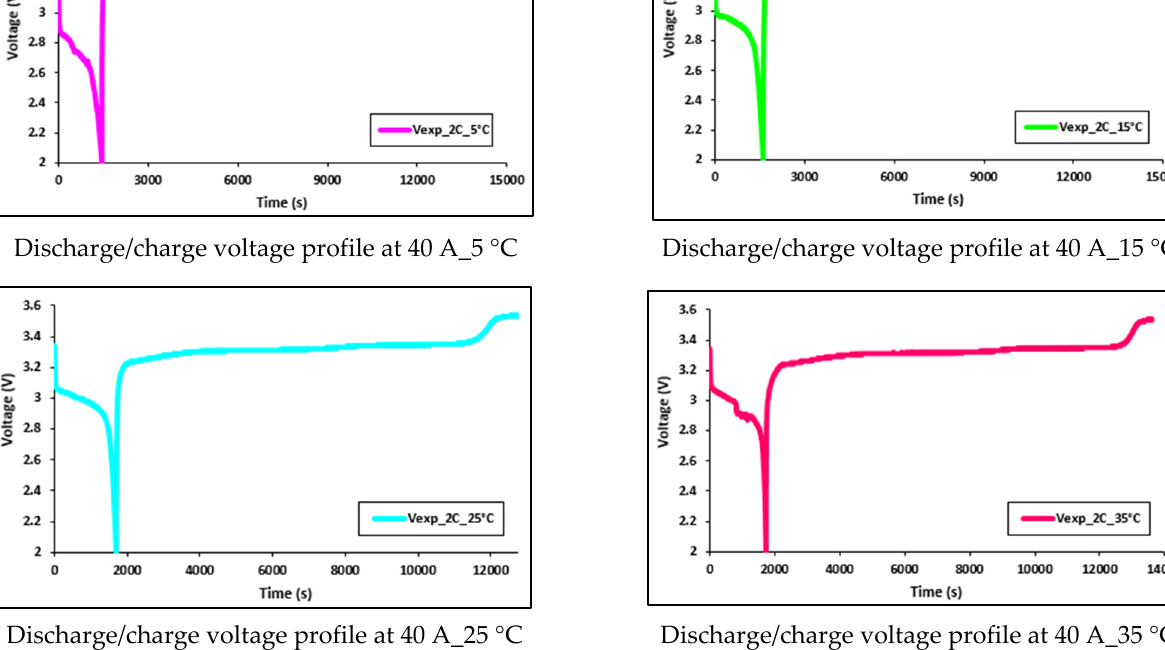
Figure 20. Discharge/charge voltage profile at 40 A with 5 °C, 15 °C, 25 °C, and 35